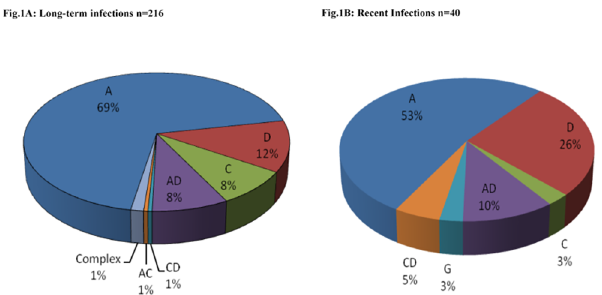
Fig 1. Distribution of HIV-1 subtypes among participants, by recency of infection, Western Kenya, October 2003-May 2005. (A) Long term ( > 239 days) (B) recent infections ( (cid:1) 239 days) (Fig 1B). A, C, D, G represent pure subtypes while AD, AC, CD are unique recombinant forms, CRF; Complex recombinants forms.